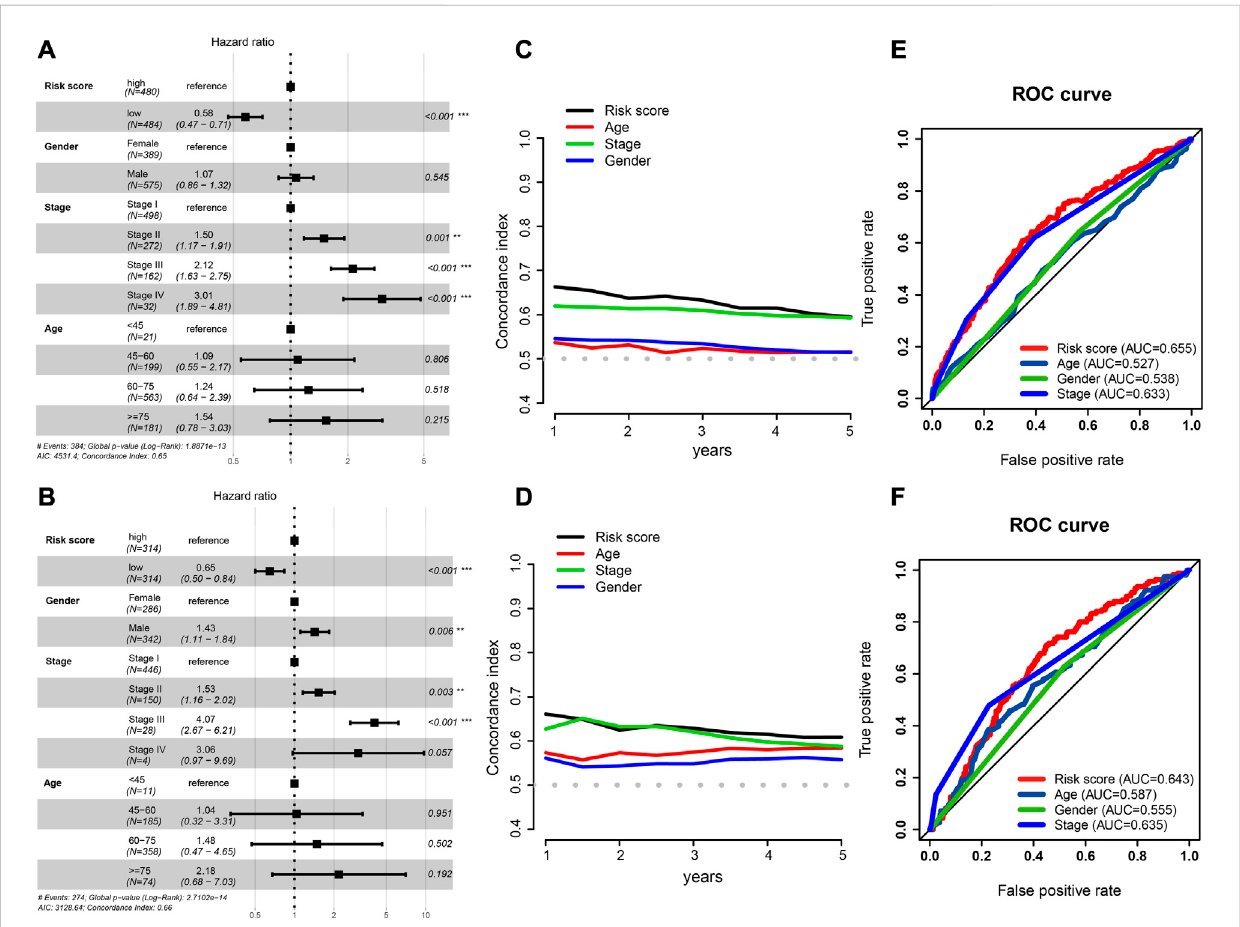
FIGURE 5 Independent prognostic factor determination and predictive accuracy comparison. (A,B) Results of TCGA cohort (A) and GEO cohort ’ s multivariate Cox regression analysis (B) . (C,D) Concordance index curve of 3 clinical parameters and risk scores for OS time from 1 to 5 years, (C) TCGA cohort, (D) GEO cohort. (E,F) Multi-index ROC curve of the risk score and other clinical parameters for 3-year OS time, TCGA cohort (E) and GEO cohort (F)